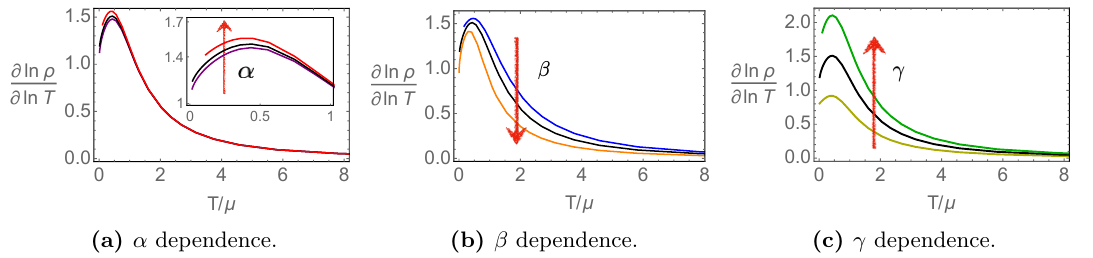
Figure 10. The exponent x in (cid:26) (cid:24) T x . The colors of the curves are chosen to be the same as the colors of the dots in (cid:12)gure 9.